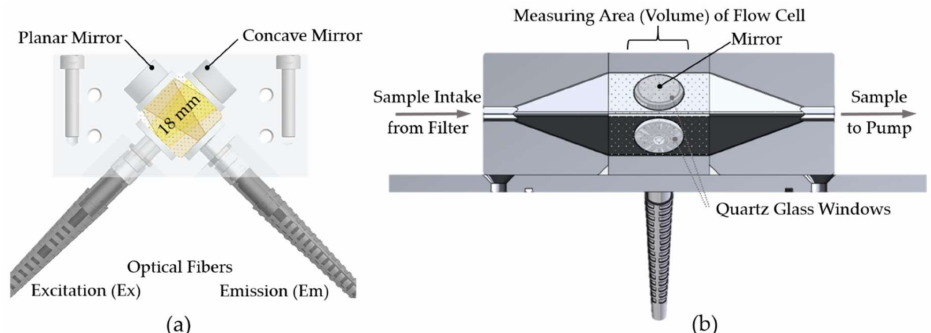
Figure 3. Details of the EEMS sensor system sample flow-through cell. ( a ) Measuring area-section with right angle arrangement of the excitation and emission optical fibers including the concave and planar mirror, respectively. ( b ) Cut-section through the flow-through cell with media intake and quartz glass